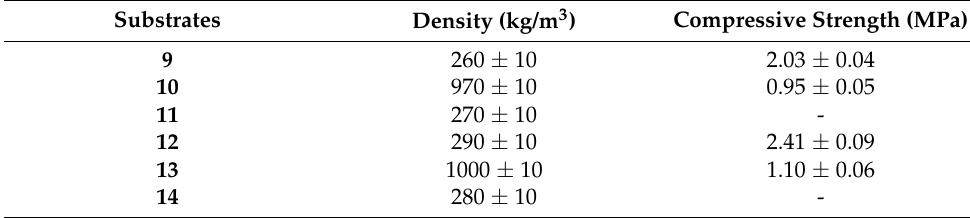
Table 3. Mechanical properties of PUs 9–11 and PU composites 12–14